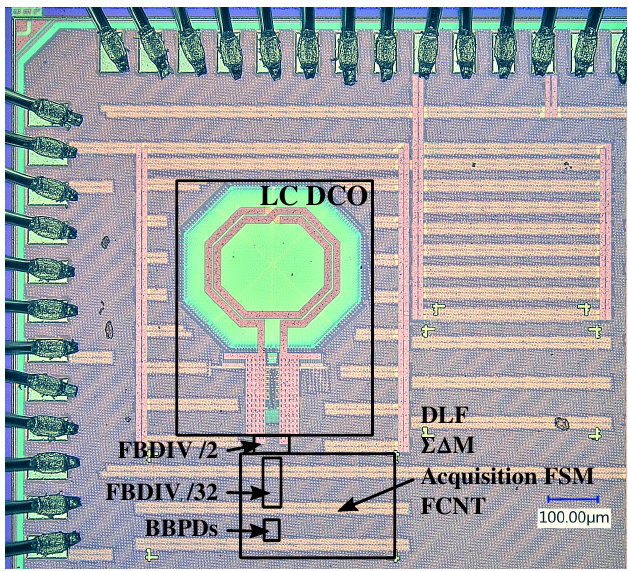
Figure 2. Photomicrograph of the All-Digital PLL/CDR circuit. The LC DCO occupies the majority of the circuit area. Critical digital components are implemented as small cells, while the remaining logic implemented in a sea-of-logic